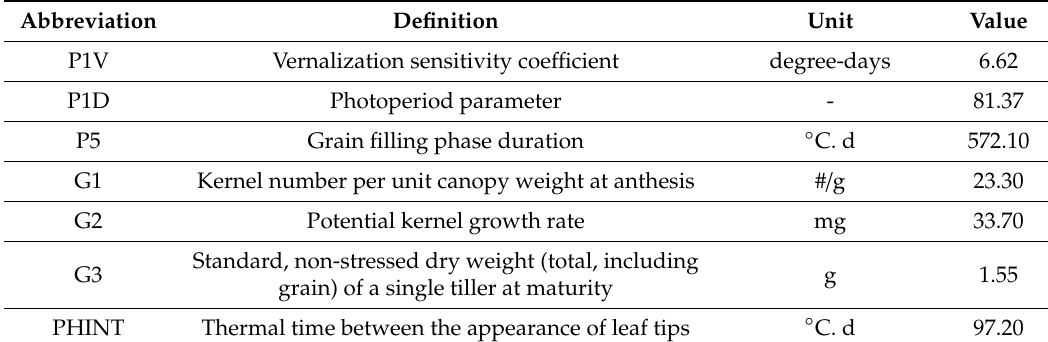
Figure 1. Location of the study area. Table 1. Validated “Xiaoyan 22” wheat cultivar parameters.